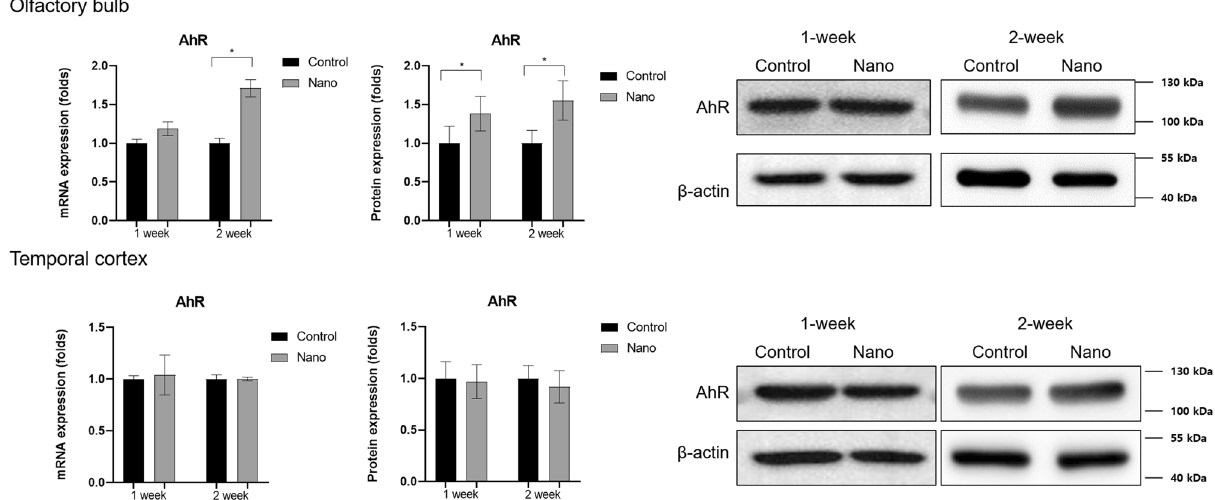
Figure 4. Comparisons of protein and mRNA expression levels of the aryl hydrocarbon receptor (AhR) in the olfactory bulb and temporal cortex between the control and nano groups (n = 8 per group for western blotting and n = 9 per group for qRT-PCR). Both protein and mRNA expression levels of AhR increased in the olfactory bulb in the nano group post-exposure. *, P < 0.05, unpaired t-test, control vs. nano